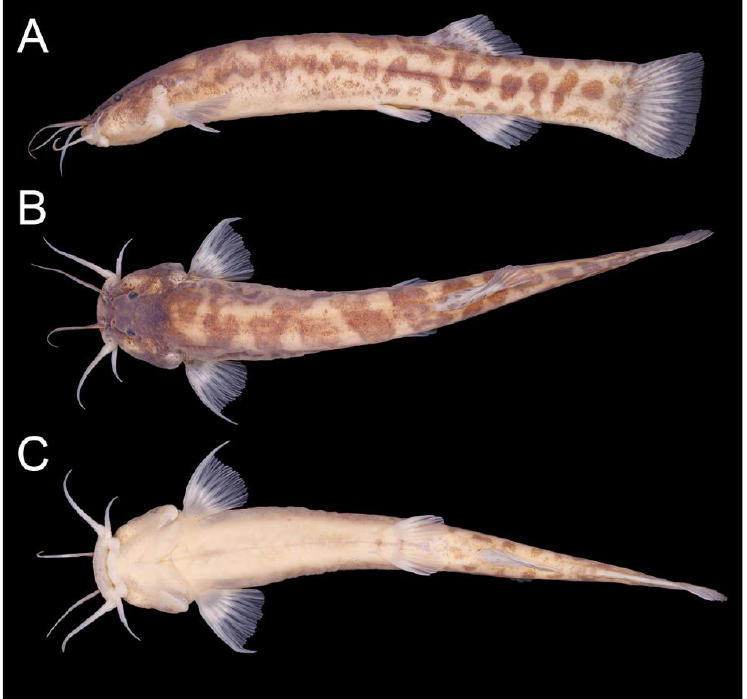
Figure 11. Trichomycterus jacupiranga , UFRJ 12781, 79.5 mm SL: ( A ) lateral, ( B ) dorsal, and ( C ) ventral views.